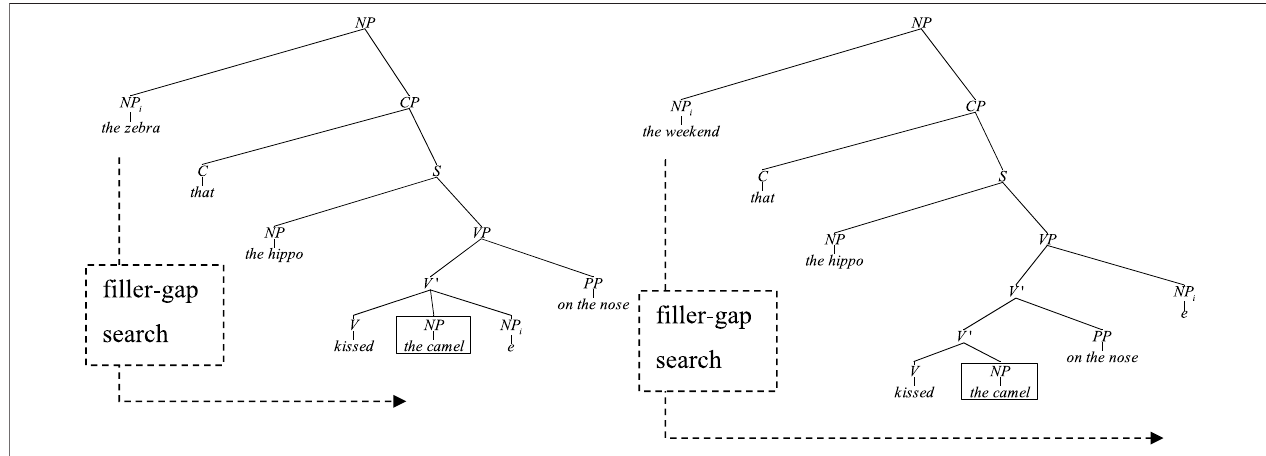
FIGURE 1 | Parse trees for experimental ( fi lled gap) and control condition stimuli